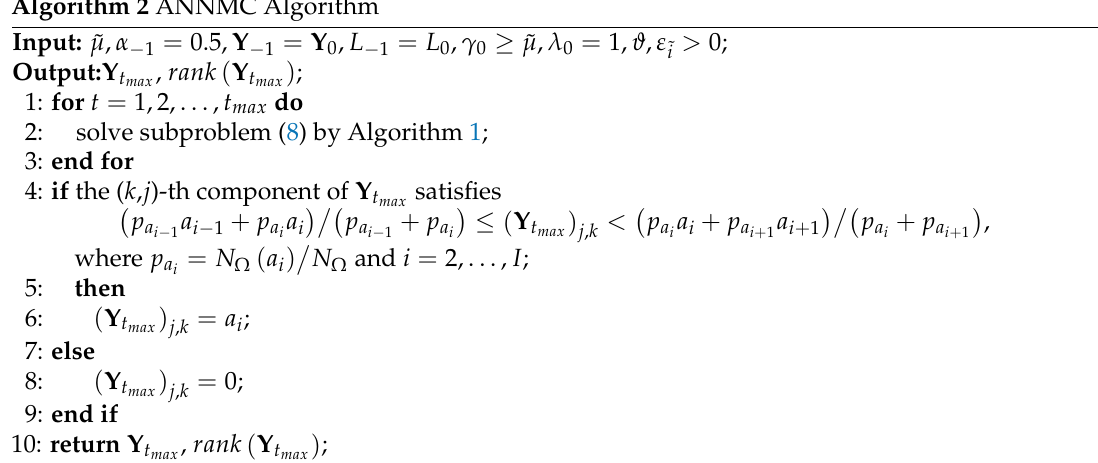
Algorithm 2 ANNMC